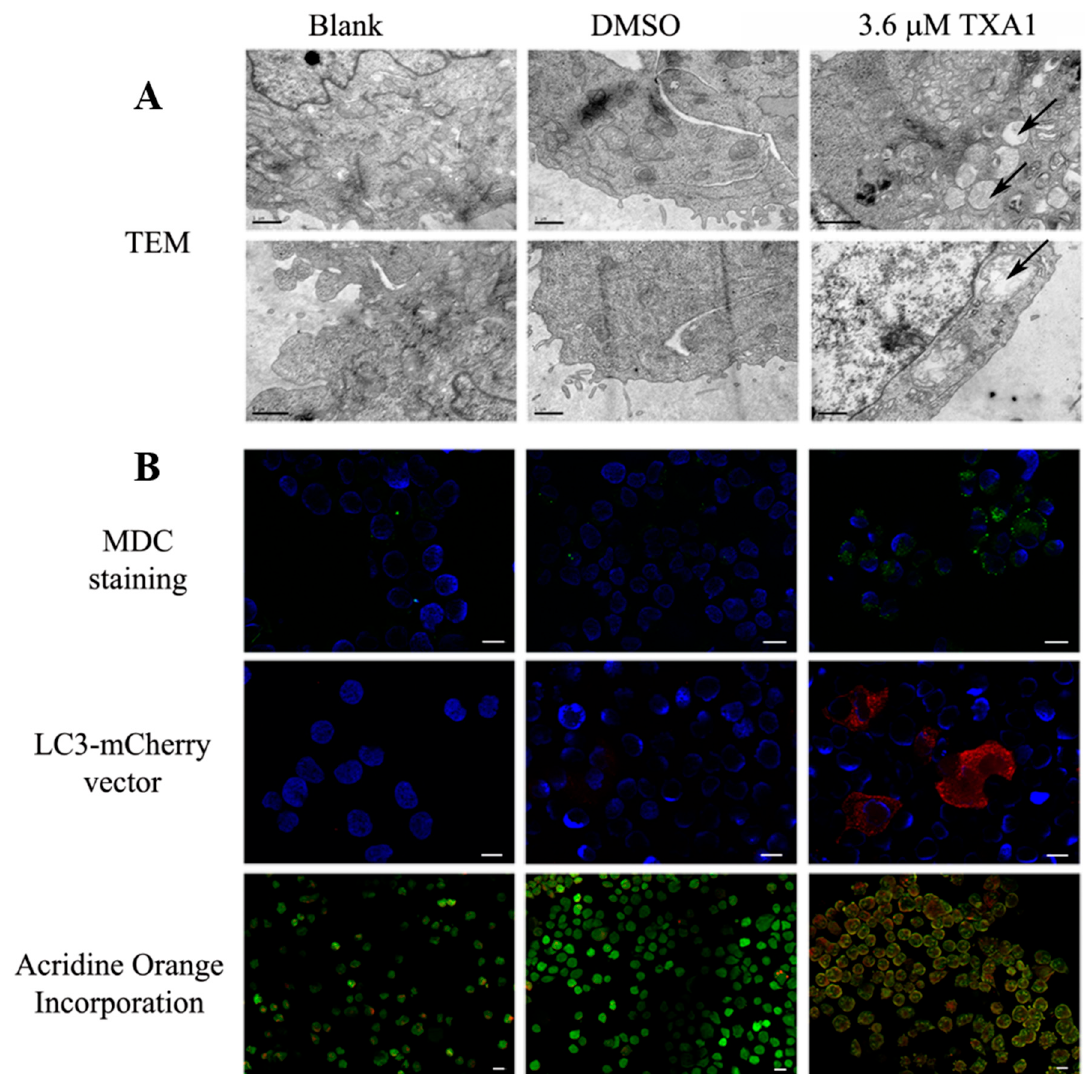
Figure 4. The effect of TXA1 on A375-C5 cellular autophagy. Cells were treated for 48 h with medium (blank), TXA1 (3.6 μ M) or with the corresponding concentration of DMSO. ( A ) Transmission electron microscopy (TEM). Images are representative of two independent experiments. Arrows indicate autophagic structures. Bar corresponds to 1 μ m; ( B ) Fluorescence microscopy analysis after (top panel) MDC staining (green); (middle panel) transfection with LC3-mCherry vector (red); and (lower panel) acridine orange incorporation (orange-red). Cell nuclei are stained with DAPI (blue). Bar = 20 μ m. Images are representative of two experiments (except for MDC assay which is representative of three experiments).